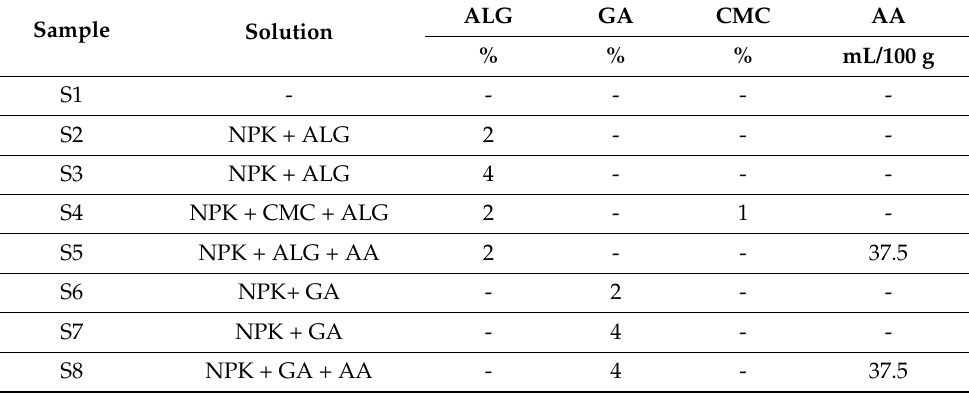
Table 1. Composition of seeds coating solutions (ALG—sodium alginate, GA—gum arabic, CMC— carboxymethyl cellulose, AA—amino acid